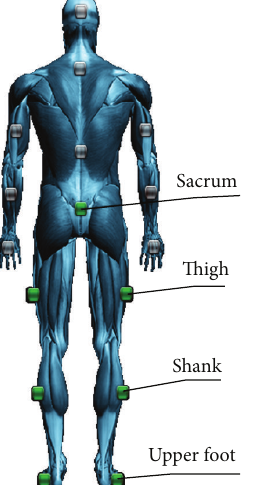
Figure 1: The places of deployment of inertial sensors (based on 16- joint-segment rigid-body model from MR3